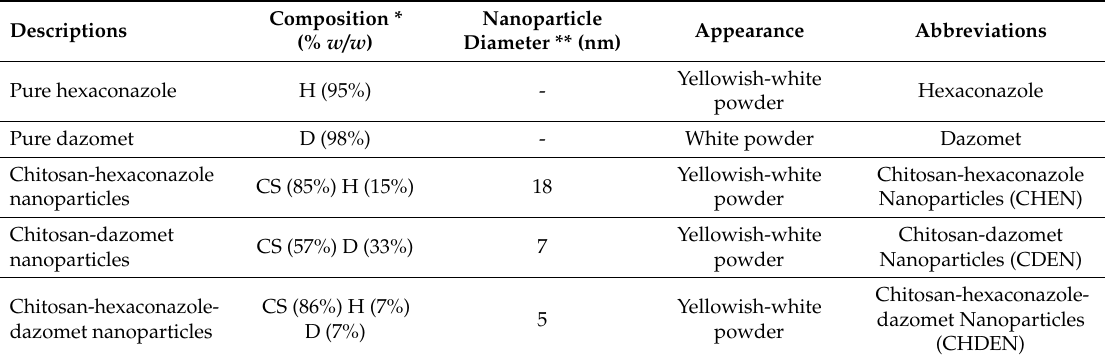
Table 1. Pure fungicide and formulated chitosan-based